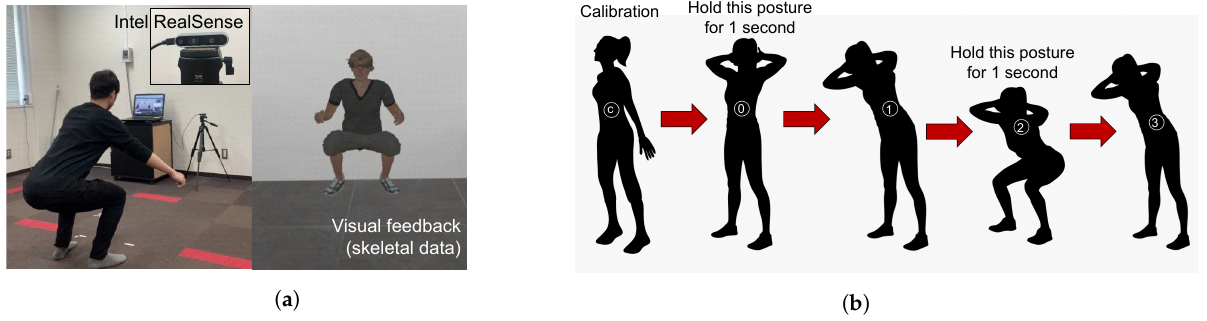
Figure 1. Experiment protocols followed during squat. The posture of arms was not restricted in any experiment. Users were free to keep their arms folded or otherwise as per their preference. ( a ) Squat posture maintained along with the visual feedback given to the user. ( b ) Different states followed during one squat. Table 1. Parameters considered for the squat motion measurement. Here, the units of angle, shakiness, and time-based parameters are degree, meter, and second,